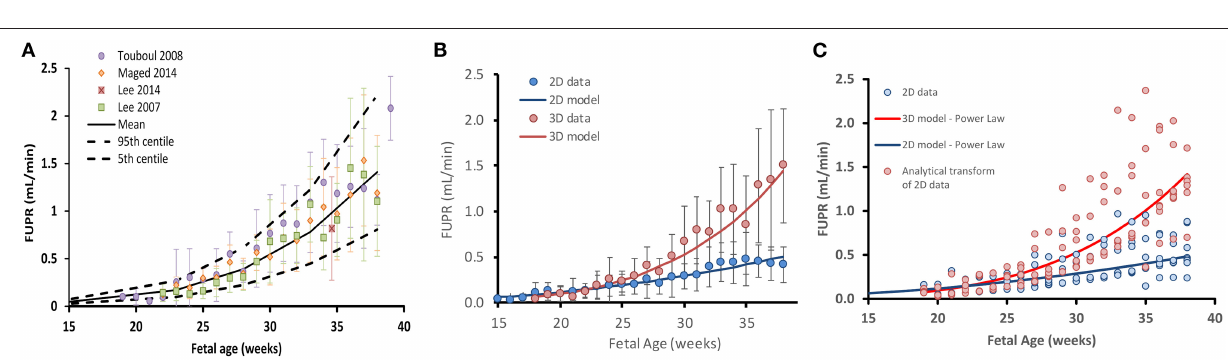
FIGURE 1 | Gestational age plotted against hourly fetal urine production rate (FUPR) as measured either by 2D (A) or 3D (B) ultrasonic technique. Each data point is the mean FUPR from the subjects detailed in the studies shown in the legend for each age. The number of subjects averaged for each point are represented by the width of the bubble, ranging from, in A, n = 1 ( 26) to n = 39 (22) at week 38, and, in B to n = 14 (20) at week 33. Inset shows the data for estimates of FUPR calculated from either the 2D or 3D ultrasound techniques from 35 gestational weeks to term. Boxes: interquartile range. Median: midline. Crosses: mean. Whiskers: maximum and minimum.